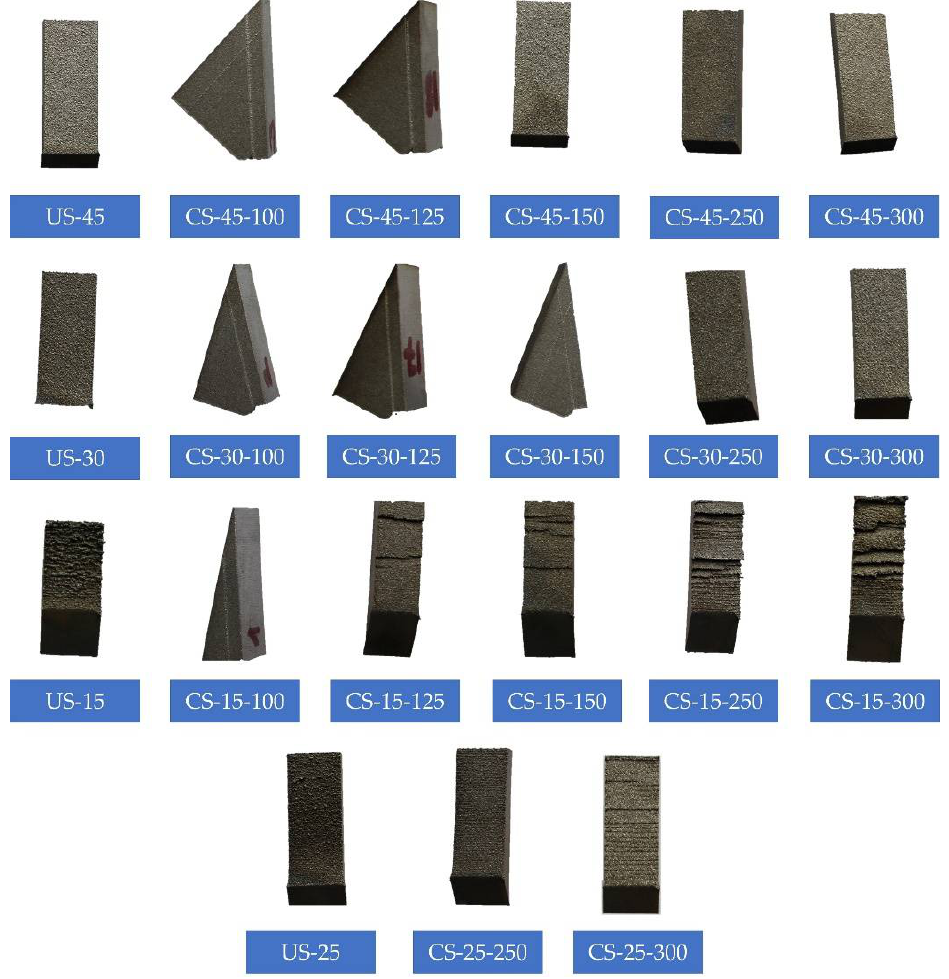
Figure 2. Contact-free supported geometries printed via DMLM (Coupons like pyramids are the ones that fused to support. Remaining ones represent overhang areas of corresponding coupons).